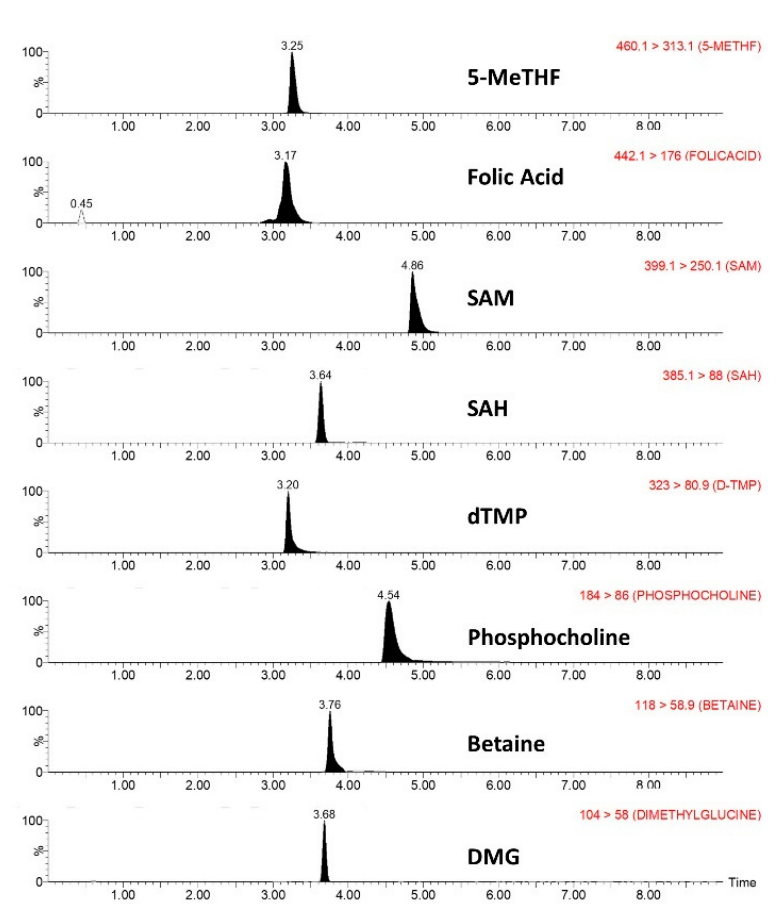
Figure 1. Representative UPLC–ESI MS/MS chromatograms of plasma samples spiked with the an- alytes.